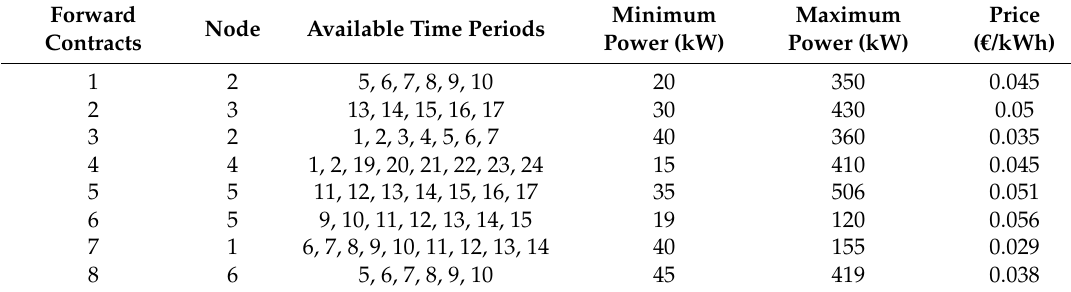
Table 2. Characteristics of forward contracts.